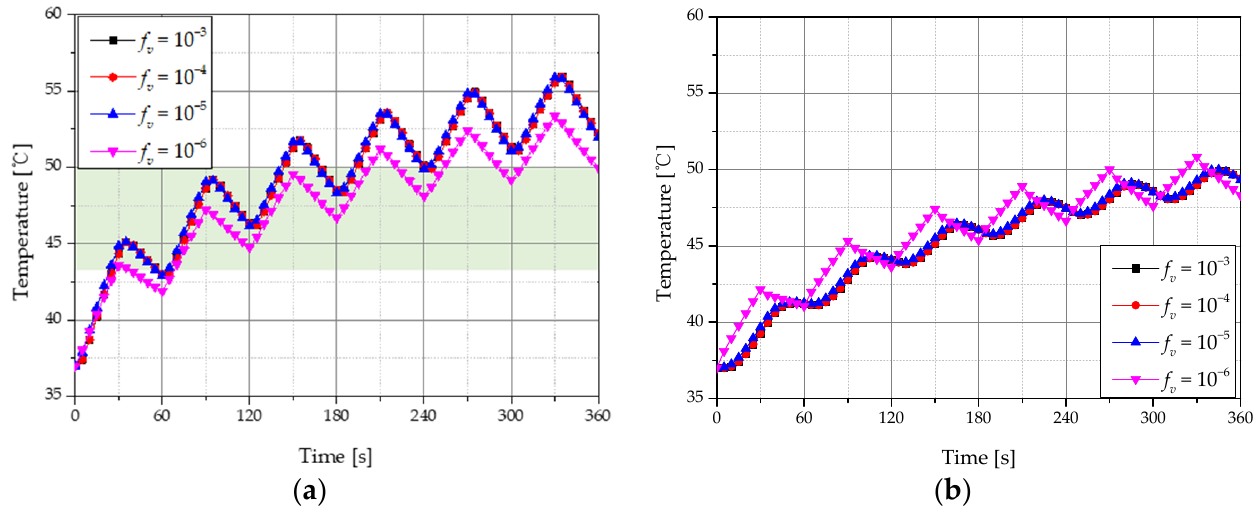
Figure 7. Temperature change with 30 s heating and cooling time for various volume fractions of GNR ( a ) tumor tissue (depth: 2 mm); ( b ) normal tissue (depth: 4 mm).